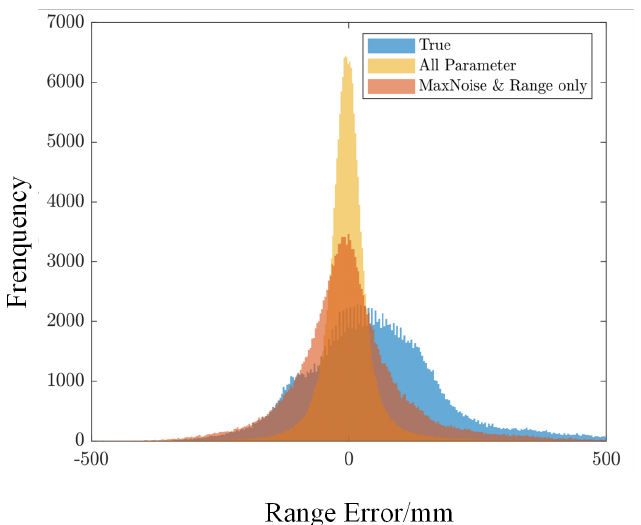
Figure 8. Effect of CNN-based NLOS error